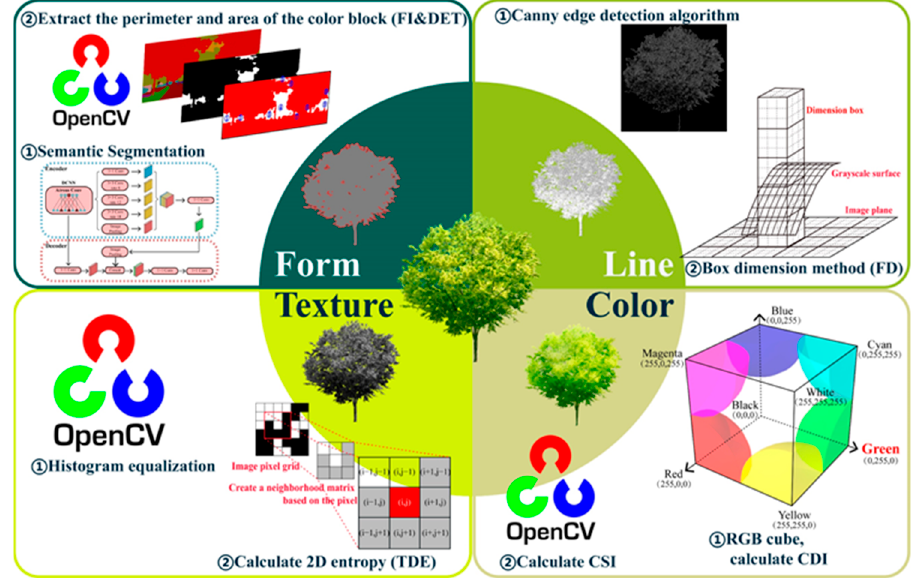
Figure 4. Deconstruction method of street green space morphology and effect demonstration.